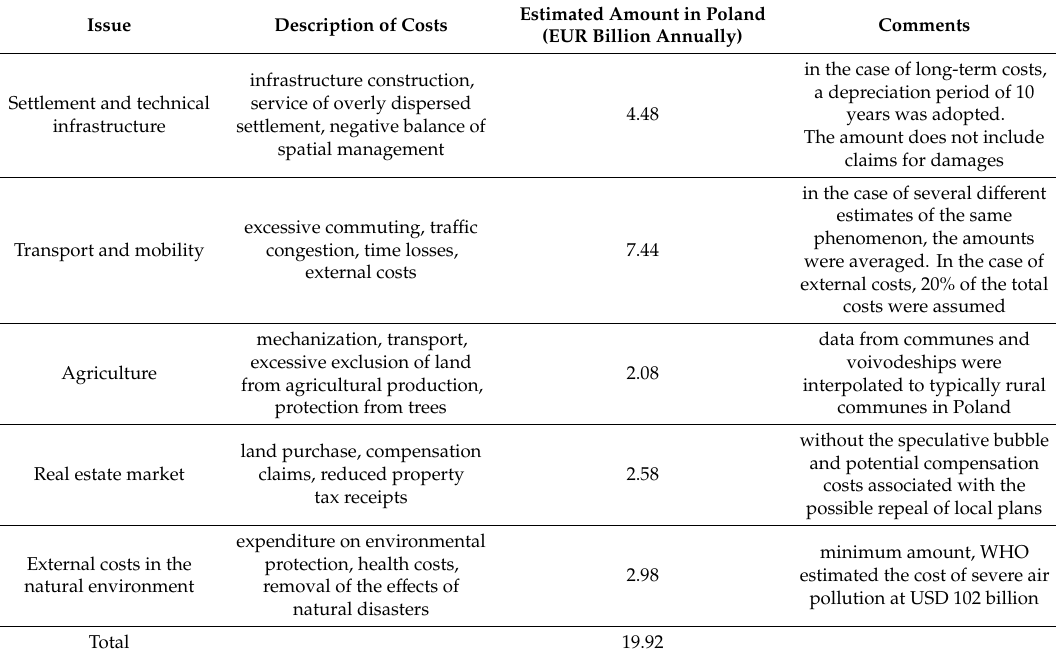
Table 2. Costs of spatial chaos in Poland by type of